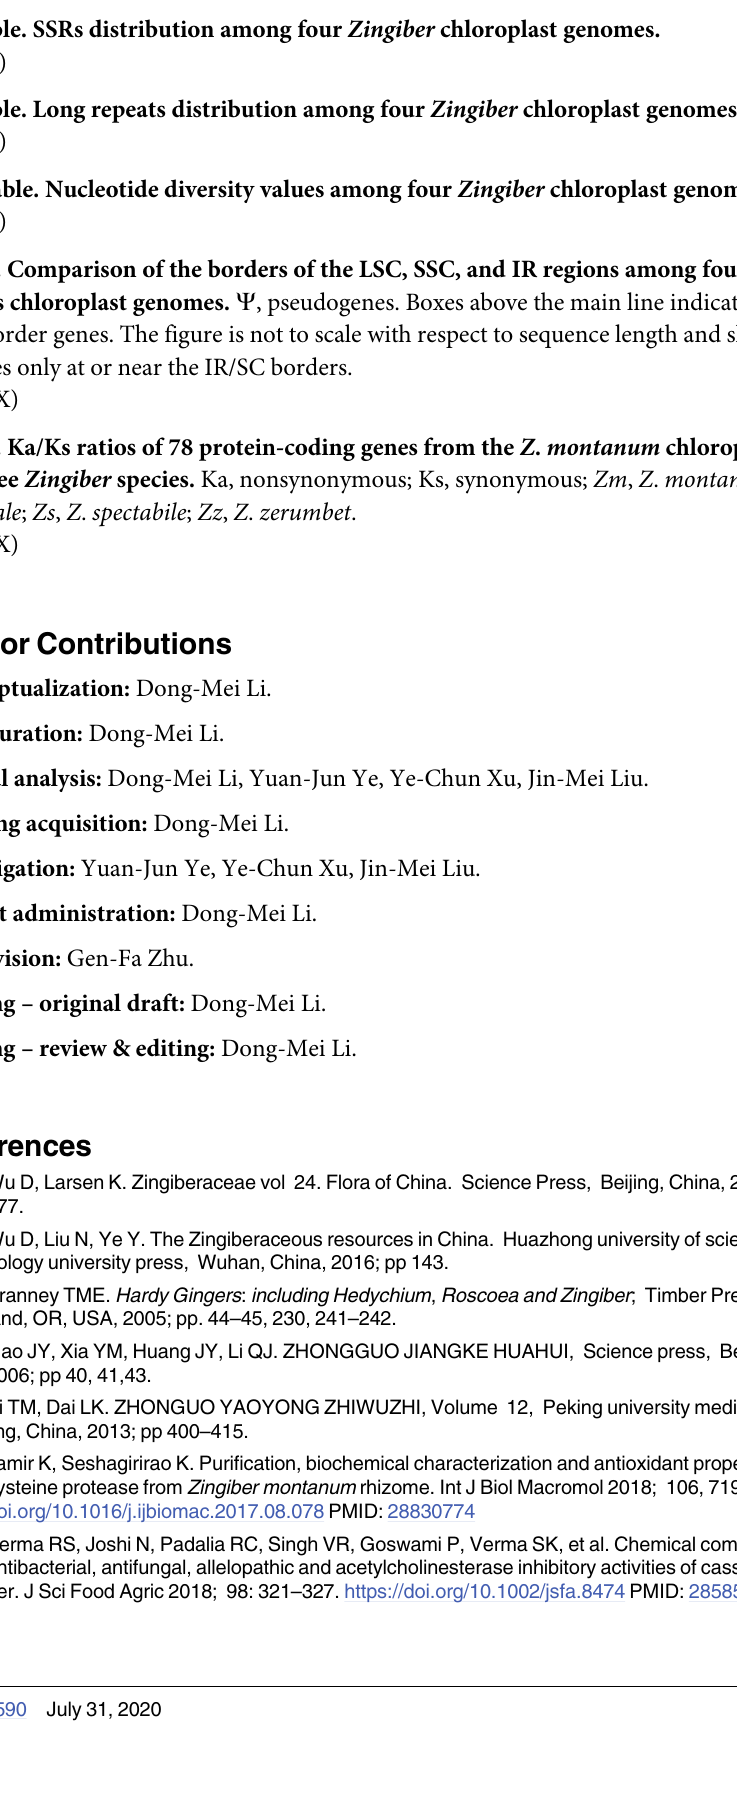
S8 Table. SSRs distribution among four Zingiber chloroplast genomes. S9 Table. Long repeats distribution among four Zingiber chloroplast genomes. S10 Table. Nucleotide diversity values among four Zingiber chloroplast genomes. S1 Fig. Comparison of the borders of the LSC, SSC, and IR regions among four Zingiber species chloroplast genomes. C , pseudogenes. Boxes above the main line indicate the adja- cent border genes. The figure is not to scale with respect to sequence length and shows relative changes only at or near the IR/SC borders. S2 Fig. Ka/Ks ratios of 78 protein-coding genes from the Z . montanum chloroplast genome vs. three Zingiber species. Ka, nonsynonymous; Ks, synonymous; Zm , Z . montanum ; Zo , Z